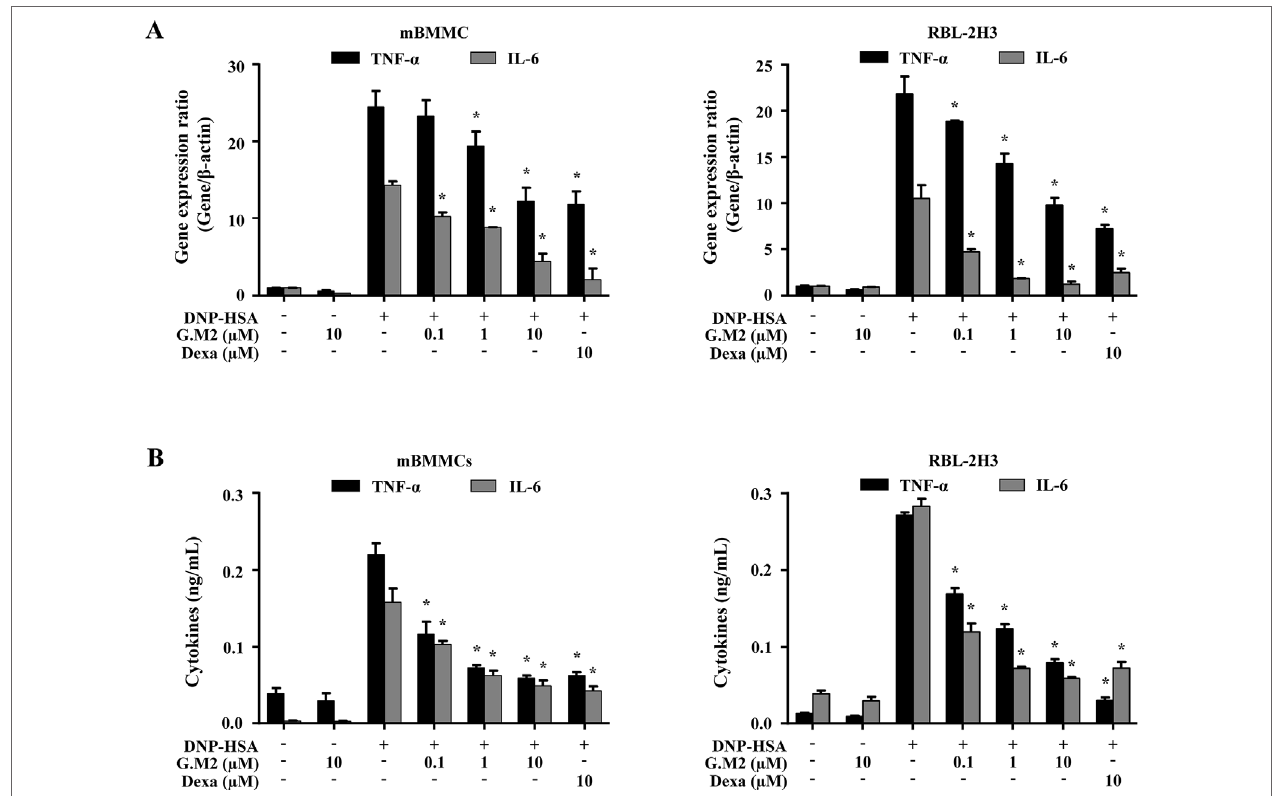
FIGURE 3 | Effects of G.M2 on expression and release of inflammatory cytokines in mast cells. Anti-DNP IgE–sensitized mBMMCs and RBL-2H3 (5 × 10 5 cells/well in 12-well plates) were pre-treated with or without G.M2 and Dexa for 1 h and then challenged with DNP-HSA (100 ng/ml). (A) The gene expression of inflammatory cytokines was determined by qPCR in mBMMCs and RBL-2H3. (B) The release of inflammatory cytokines was measured by enzyme-linked immunosorbent assay (ELISA) in mBMMCs and RBL-2H3. Each dataset presented as a graph represents the means ± SEM of three independent experiments. * p < 0.05, compared with the DNP-HSA-challenged group. Dexa,